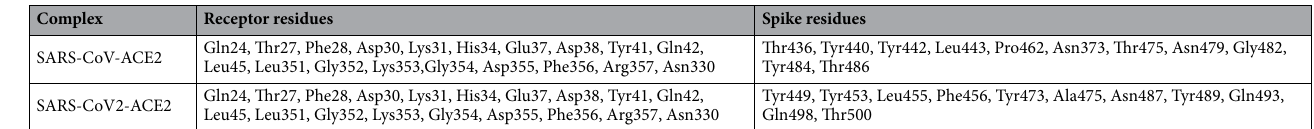
Complex Receptor residues Spike residues